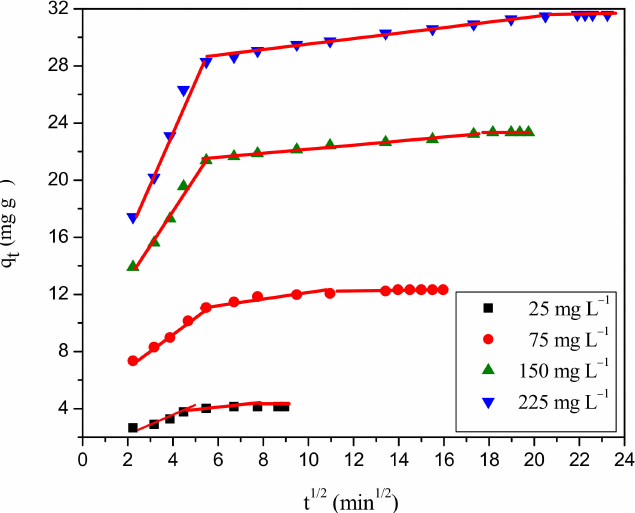
Figure 12. Intra-particle diffusion plot for adsorption of RBBR dye onto WSBAC adsorbent. (Initial pH: 2; initial dye concentration: 25–225 mg L − 1 ; WSBAC adsorbent dosage: 6 g L − 1 ; adsorbent particle size: 55.21 µ m; agitation speed: 150 rpm; temperature: 301 K; contact time: 24